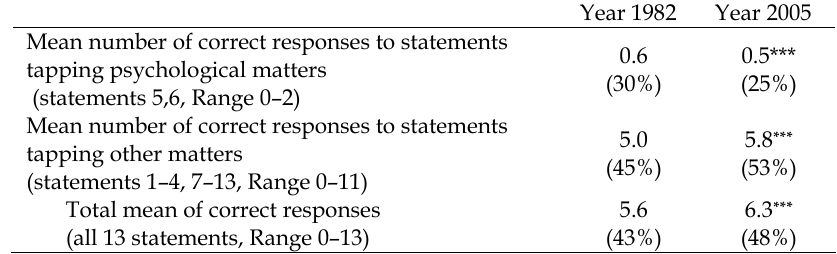
Table 3 . Average number of correct responses to statements on psycho- logical versus other matters in 1982 and 2005 . Average percent correct responses a in parentheses for better